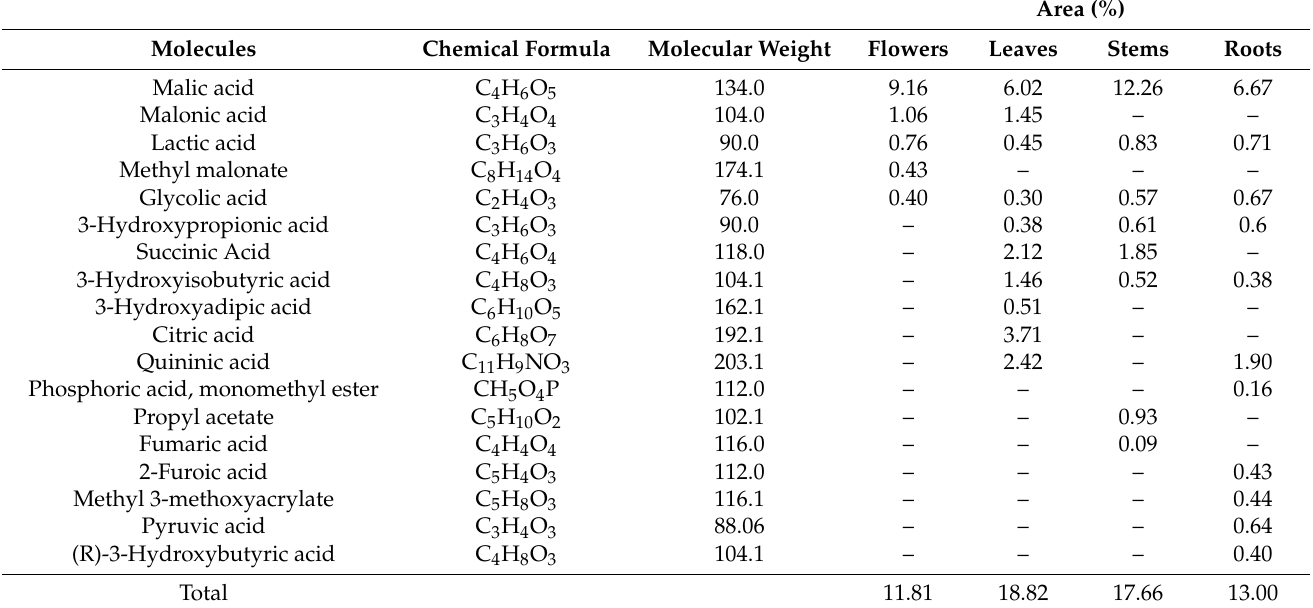
Table 5. Organic acids of derivatized methanolic extracts obtained by